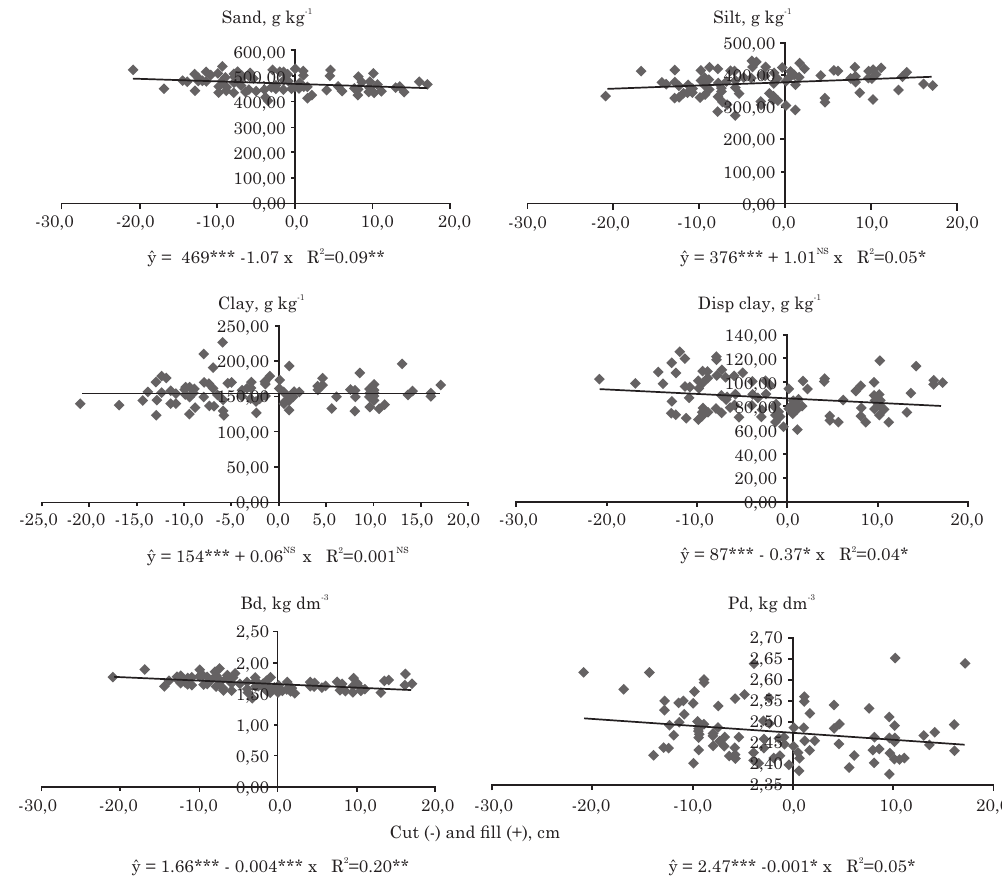
Figure 5. Regressions between cut (-) and fill (+) depths and sand, silt, clay and dispersed clay content in water (Disp clay), soil bulk density (Bd) and particle density (Pd). *** p<0.001; * p<0.05 and NS not